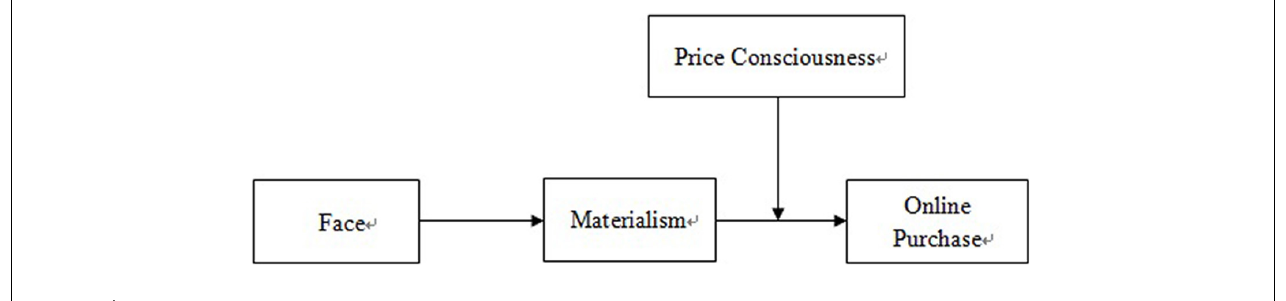
FIGURE 1 | Hypothesized conceptual model. TABLE 1 | Correlations between the variables in the